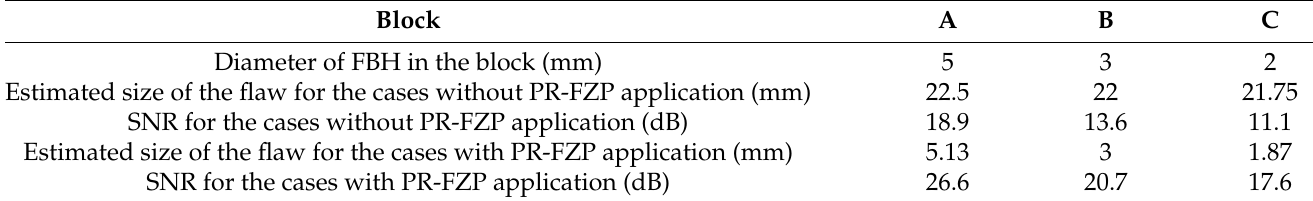
Figure 10. Lateral profiles of results obtained for block ( A ) A, ( B ) B, and ( C ) C on the X and Y axis. Table 2. Results of flaws size evaluation by using − 6 dB drop method.